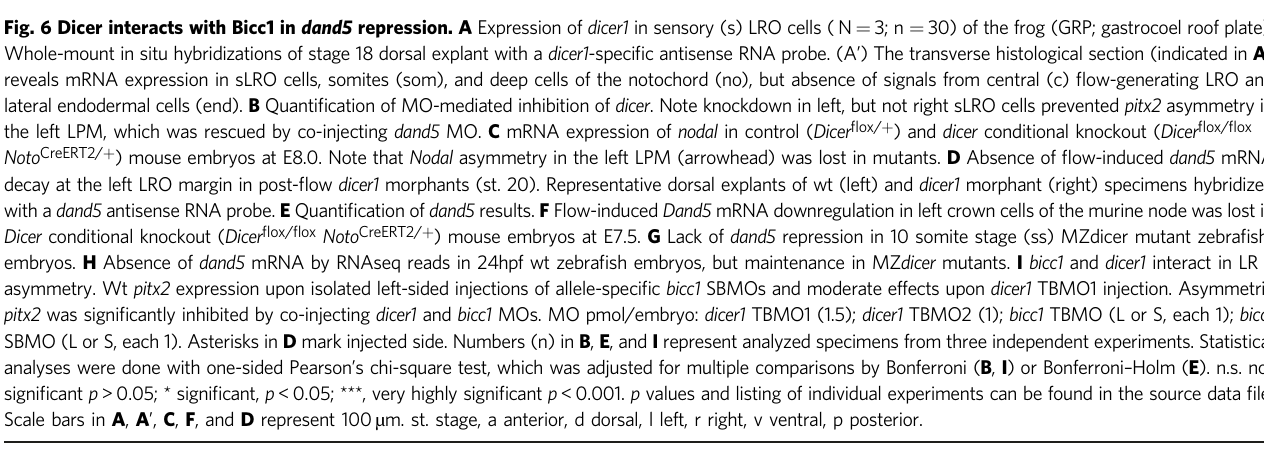
Fig. 6 Dicer interacts with Bicc1 in dand5 repression. A Expression of dicer1 in sensory (s) LRO cells (N = 3; n = 30) of the frog (GRP; gastrocoel roof plate). Whole-mount in situ hybridizations of stage 18 dorsal explant with a dicer1 -speci fi c antisense RNA probe. (A ’ ) The transverse histological section (indicated in A ) reveals mRNA expression in sLRO cells, somites (som), and deep cells of the notochord (no), but absence of signals from central (c) fl ow-generating LRO and lateral endodermal cells (end). B Quanti fi cation of MO-mediated inhibition of dicer . Note knockdown in left, but not right sLRO cells prevented pitx2 asymmetry in the left LPM, which was rescued by co-injecting dand5 MO. C mRNA expression of nodal in control ( Dicer fl ox/ + ) and dicer conditional knockout ( Dicer fl ox/ fl ox Noto CreERT2/ + ) mouse embryos at E8.0. Note that Nodal asymmetry in the left LPM (arrowhead) was lost in mutants. D Absence of fl ow-induced dand5 mRNA decay at the left LRO margin in post- fl ow dicer1 morphants (st. 20). Representative dorsal explants of wt (left) and dicer1 morphant (right) specimens hybridized with a dand5 antisense RNA probe. E Quanti fi cation of dand5 results. F Flow-induced Dand5 mRNA downregulation in left crown cells of the murine node was lost in Dicer conditional knockout ( Dicer fl ox/ fl ox Noto CreERT2/ + ) mouse embryos at E7.5. G Lack of dand5 repression in 10 somite stage (ss) MZdicer mutant zebra fi sh embryos. H Absence of dand5 mRNA by RNAseq reads in 24hpf wt zebra fi sh embryos, but maintenance in MZ dicer mutants. I bicc1 and dicer1 interact in LR asymmetry. Wt pitx2 expression upon isolated left-sided injections of allele-speci fi c bicc1 SBMOs and moderate effects upon dicer1 TBMO1 injection. Asymmetric pitx2 was signi fi cantly inhibited by co-injecting dicer1 and bicc1 MOs. MO pmol/embryo: dicer1 TBMO1 (1.5); dicer1 TBMO2 (1); bicc1 TBMO (L or S, each 1); bicc1 SBMO (L or S, each 1). Asterisks in D mark injected side. Numbers (n) in B , E , and I represent analyzed specimens from three independent experiments. Statistical analyses were done with one-sided Pearson ’ s chi-square test, which was adjusted for multiple comparisons by Bonferroni ( B , I ) or Bonferroni – Holm ( E ). n.s. not signi fi cant p >0.05; * signi fi cant, p <0.05; ***, very highly signi fi cant p <0.001. p values and listing of individual experiments can be found in the source data fi le. Scale bars in A , A ’ , C , F , and D represent 100 µ m. st. stage, a anterior, d dorsal, l left, r right, v ventral,